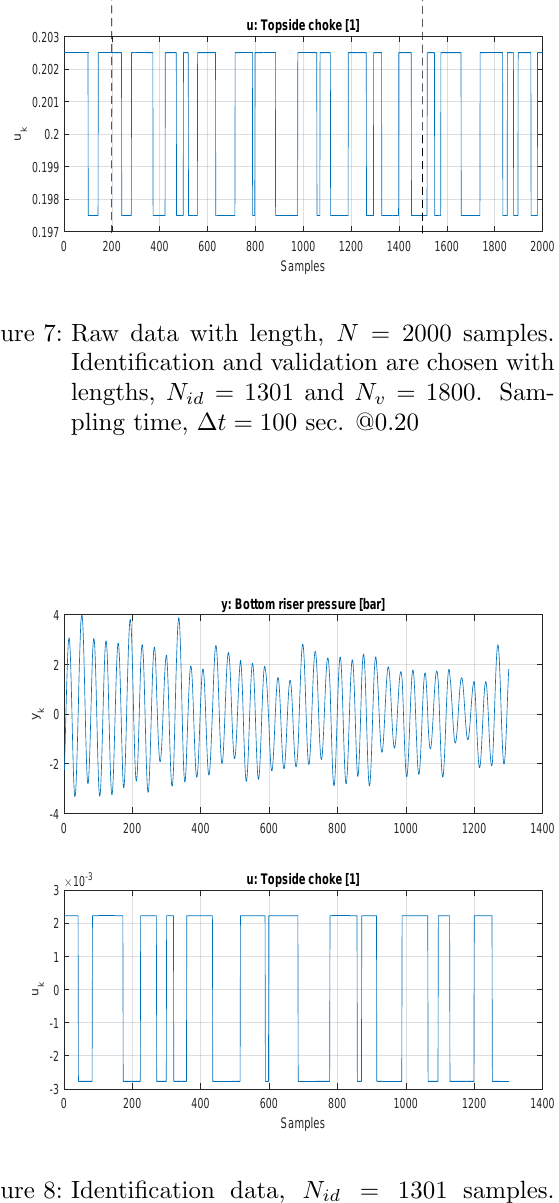
Figure 8: Identification data, N id = 1301 samples. @0.20